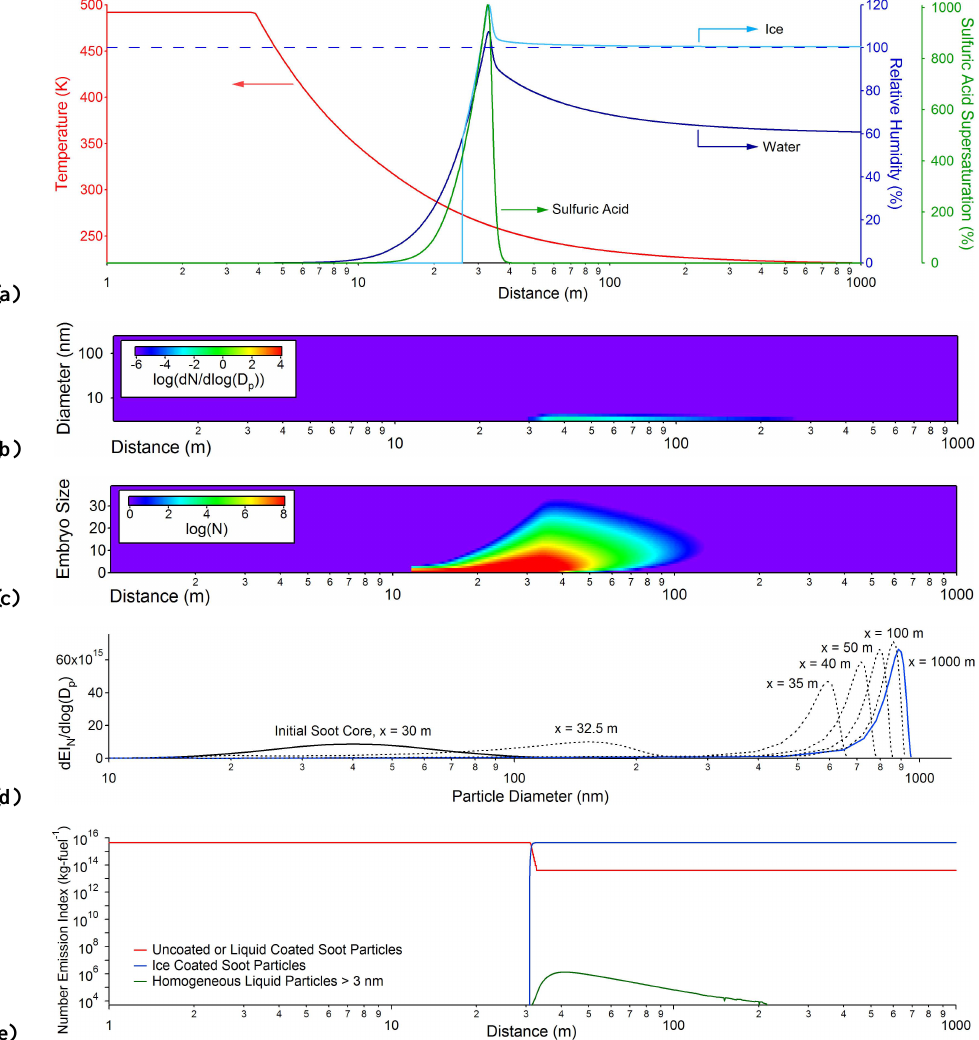
Fig. 1. Representative simulation results following the plume centerline trajectory up to 1000m downstream: (a) trajectories of plume temperature, and ice, water, and acid supersaturation as a function of downstream distance; (b) concentration and size evolution of volatile H 2 SO 4 -H 2 O droplets; (c) concentration and size evolution of volatile H 2 SO 4 -H 2 O embryos smaller than 40 acid molecules; (d) size evolu- tion of ice coated soot particles; (e) number emission index of different types of particles as a function of